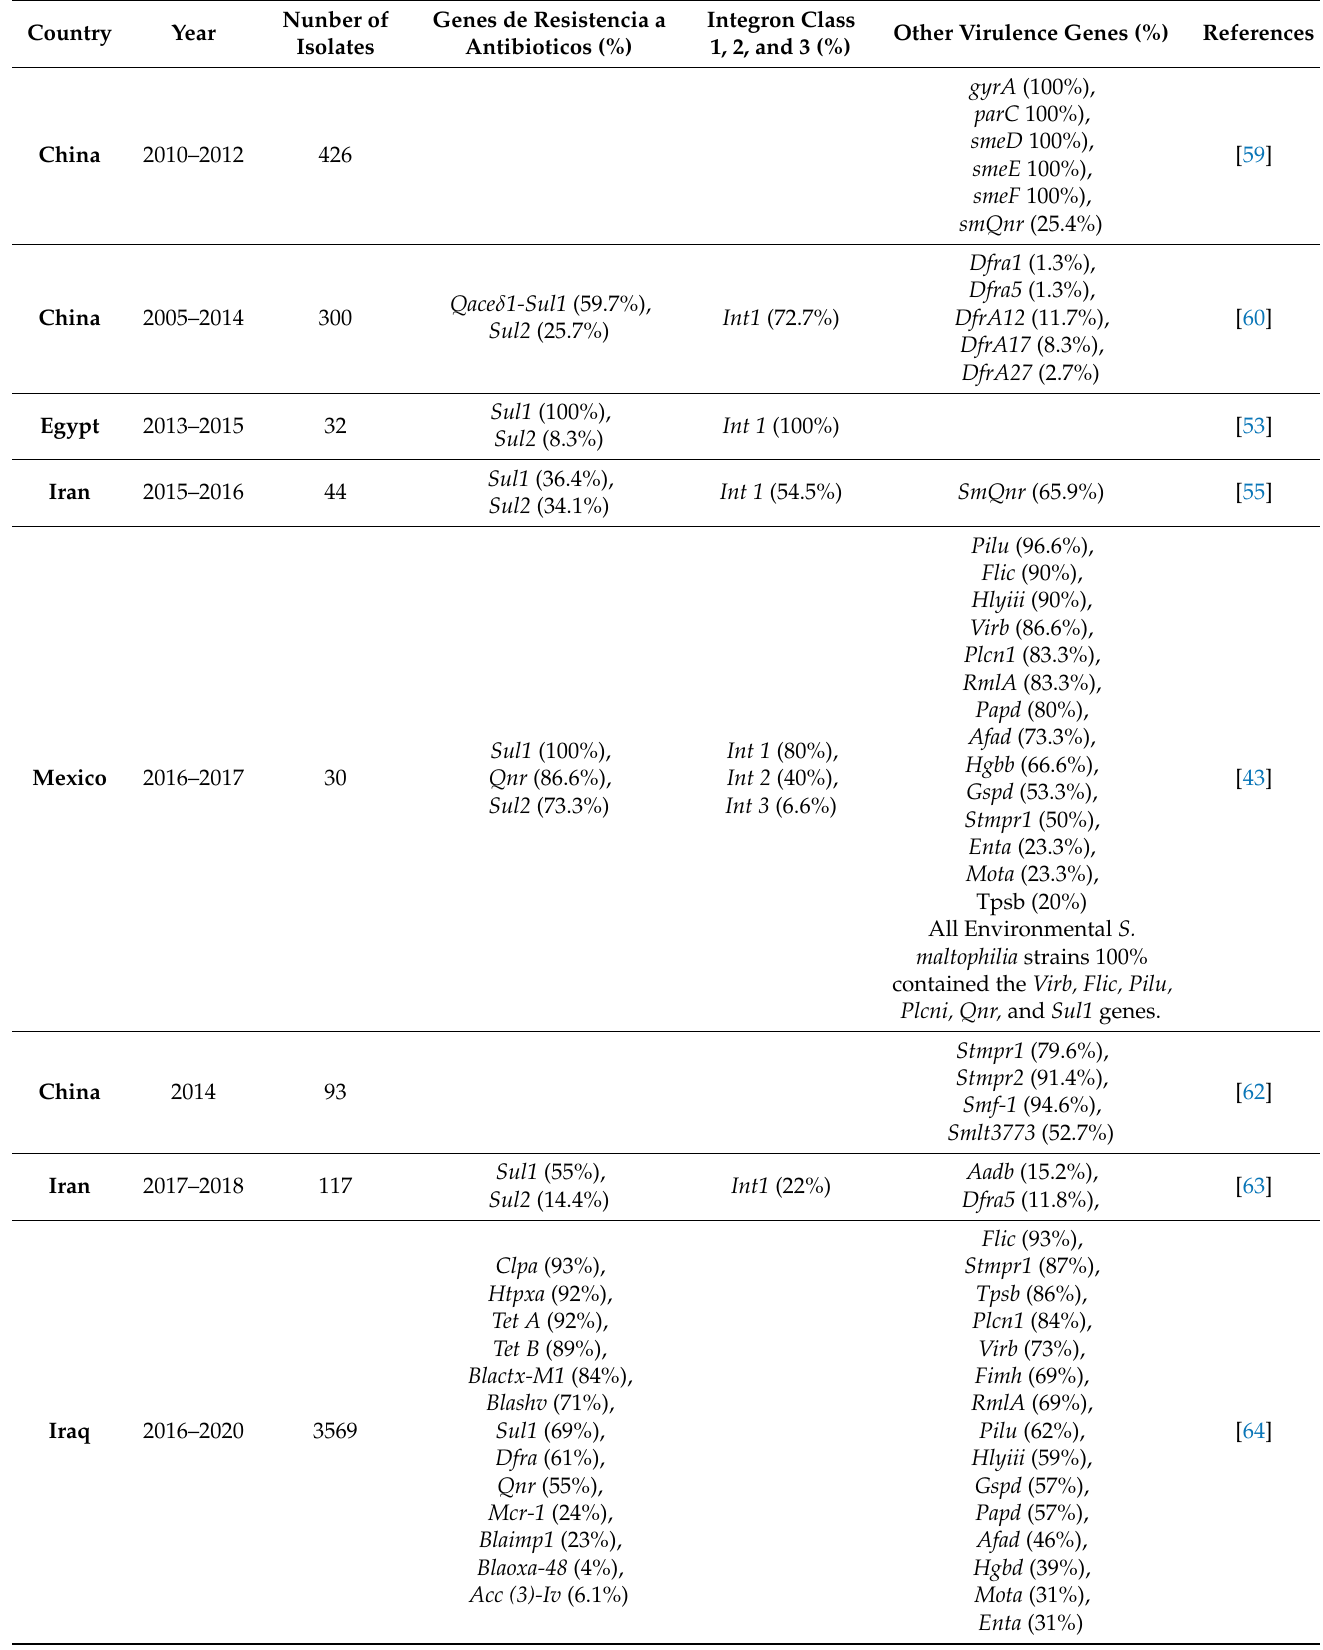
Table 2. Presence of resistance and virulence genes in S. maltophilia